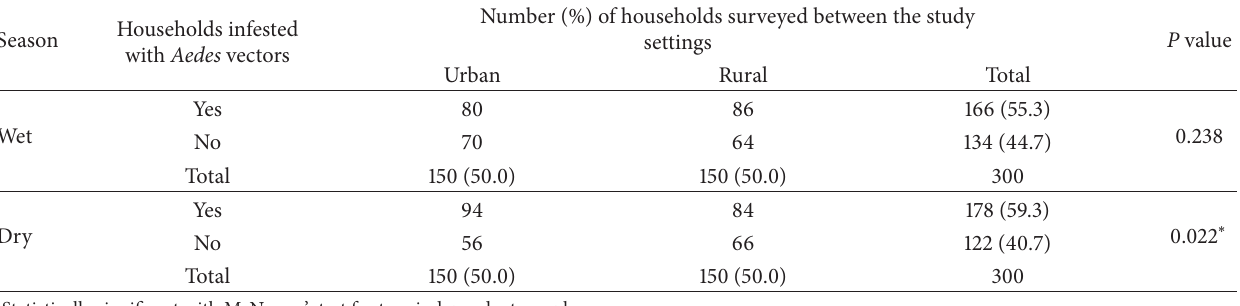
Table 3: Seasonal and geographical distributions of Aedes vectors at household level.